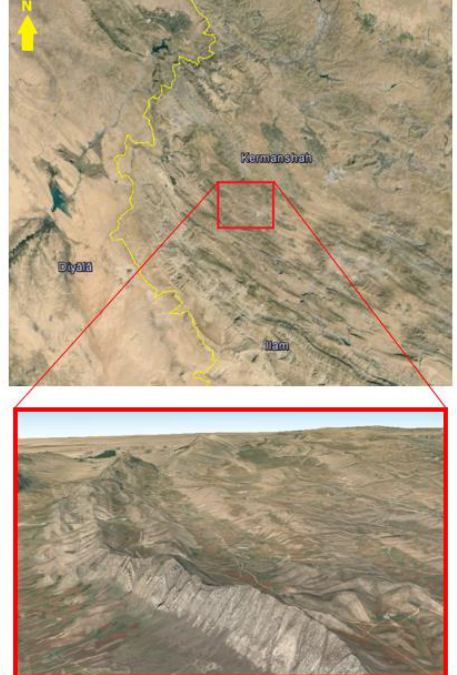
Figure 2. Study area in west of Iran